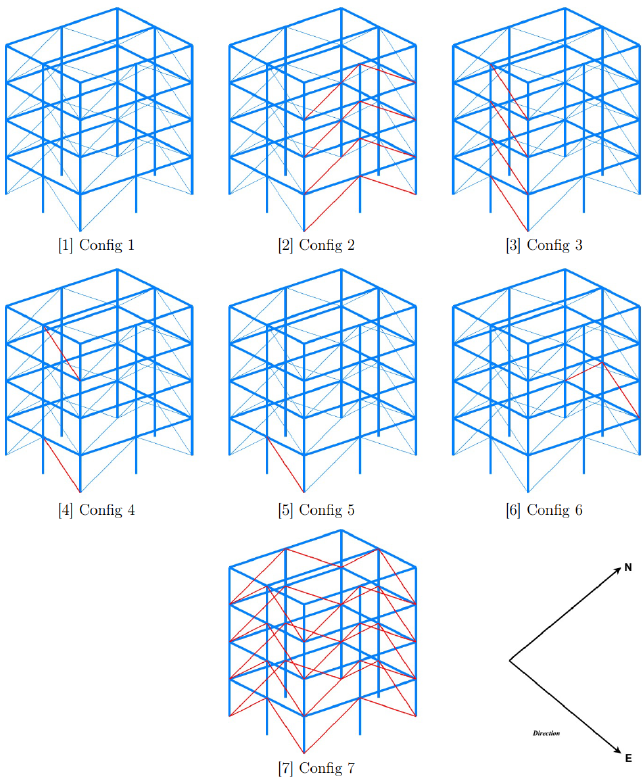
Figure 6. Seven benchmark cases of Structure 1, damage components